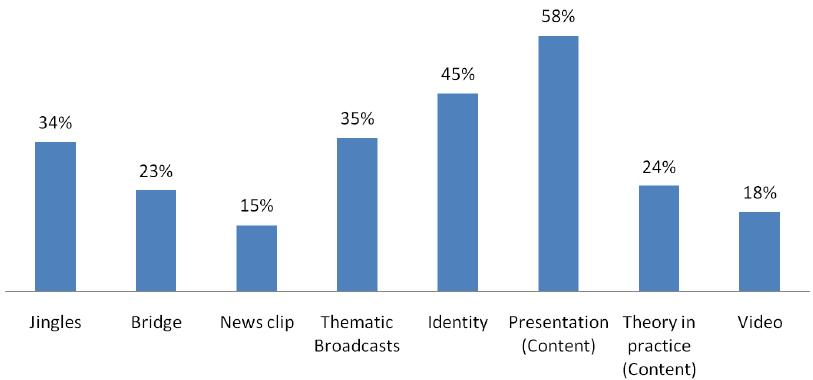
Figure 4. Grouped and adjusted qualitative data as quantitative data from the second part of the evaluation form.